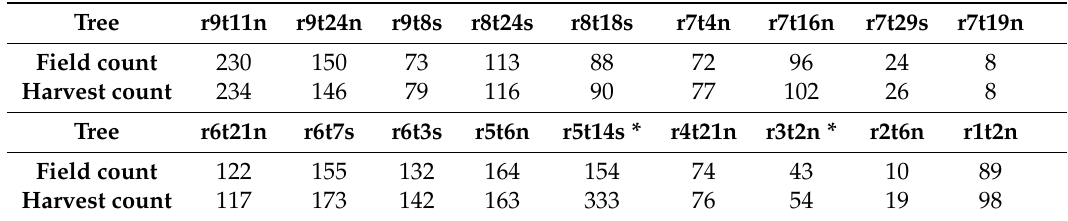
Table 1. Field and harvest mango count for 18